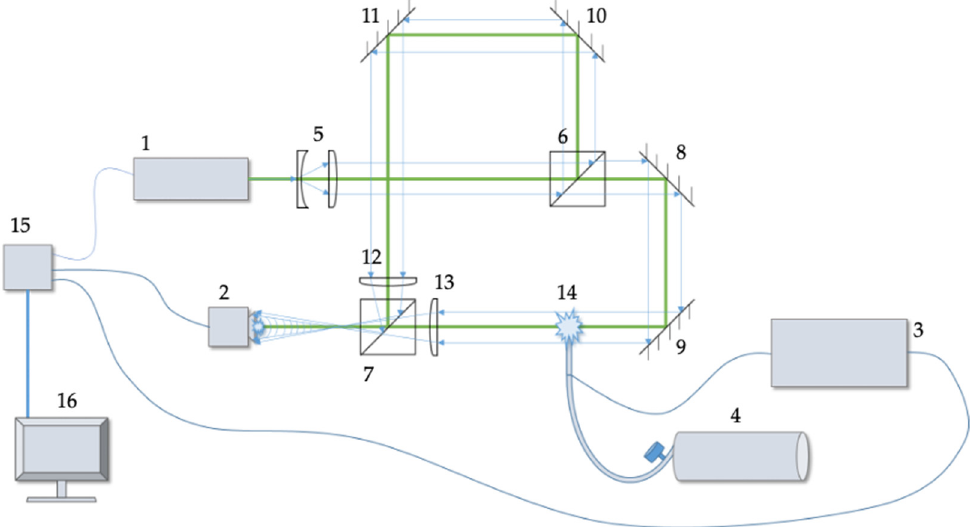
Figure 6. Configuration of the digital holographic interferometry complex for the study of plasma flow in the pulsed generation mode: (1)—Nd: YAG pulse laser, (2)—CCD Camera, (3)—pulse-plasma generator, (4)—helium container, (5)—collimator, (6, 7)—beam splitters, (8, 9, 10, 11)—mirrors, (12, 13)—lenses, (14)—plasma jet, (15)—synchronization Unit, (16)—PC.